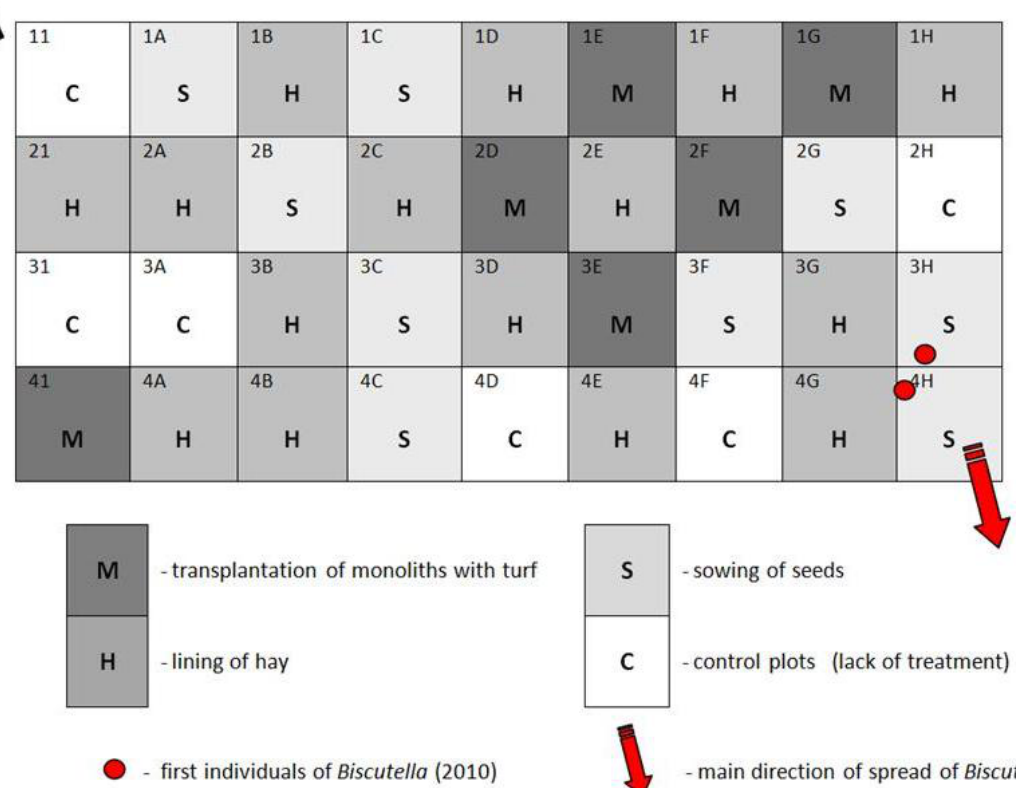
Fig. 7. The experimental layout of the plot-experiment research. The research field is divided into 36 squares (plots). Symbols inside the squares (1x1m 2 ) denote the number of each